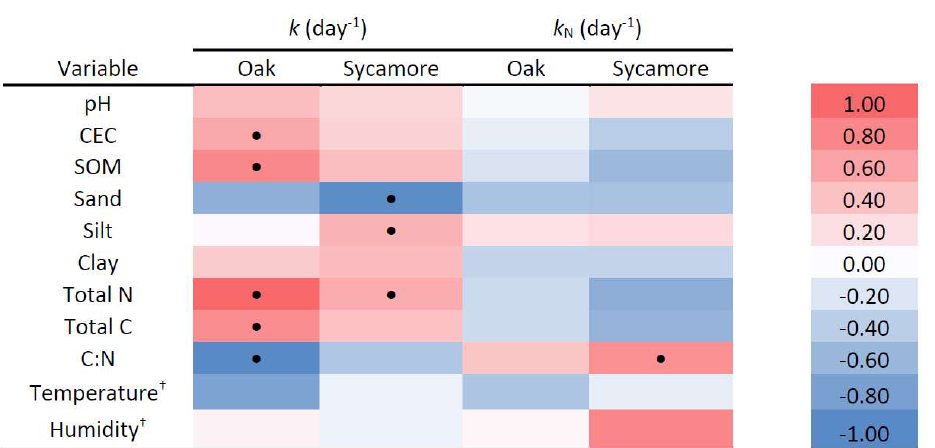
Figure 4. Mean ( ± se; n = 7) percentage of initial litter N remaining ( a ) and the N mineralization rate constant ( b ) from decomposing oak (dark-green bars) and sycamore (light-green bars) leaves. Shown also are the results of a 2-way ANOVA (F-statistic, degrees of freedom, and p -value) with species (S) and habitat (H) as fixed effects and the species x habitat interaction. In the event of a significant ANOVA for site, a Tukey–Kramer post hoc test was run to see which sites were significantly different. Means with different letters are significantly different. * p < 0.05; ** p < 0.01.